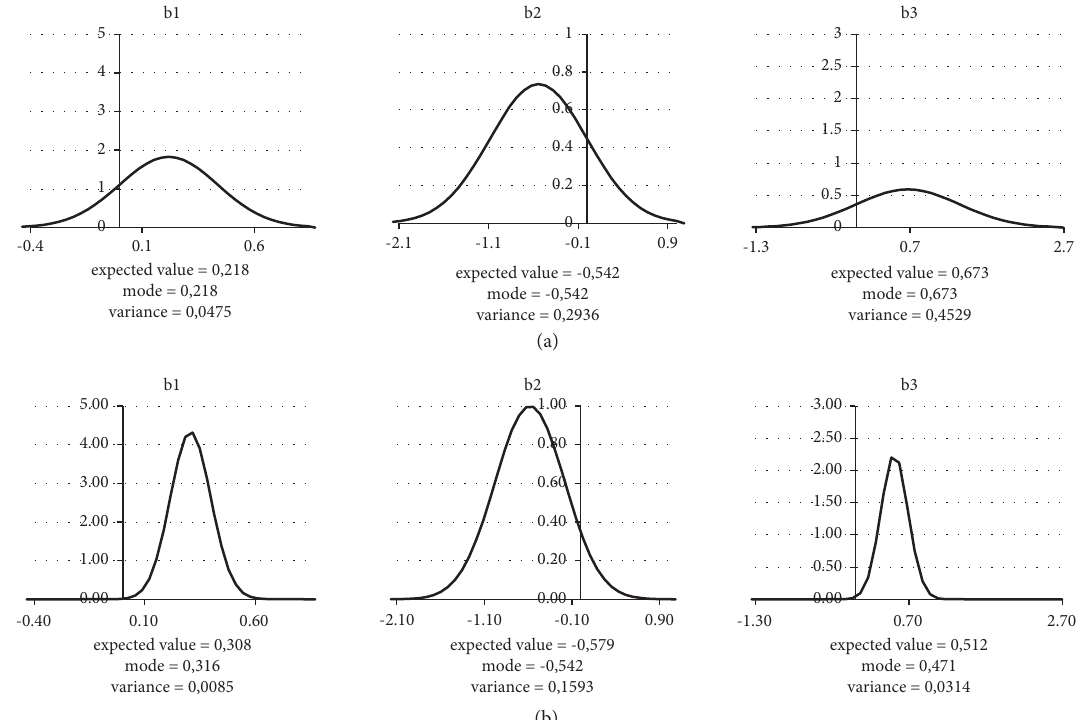
Figure 3: Prior and posterior probability of the parameters b in the experimentation case. (a) Prior probability of the parameters b over I adopted in the experimentation case. (b) Posterior probability of the parameters b over I and x obtained in the experimentation case. Table 4: Sentiment average percentage and observed frequencies evaluation in the experimental case. Sentiment